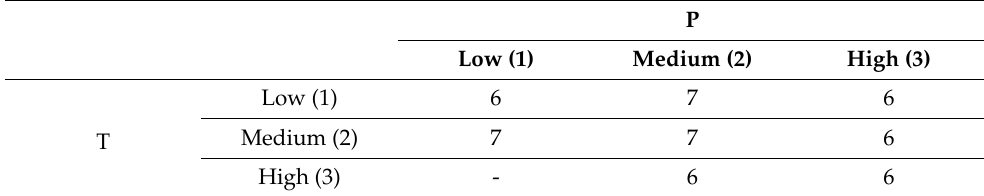
Table 6. Training, testing, and validation datasets.